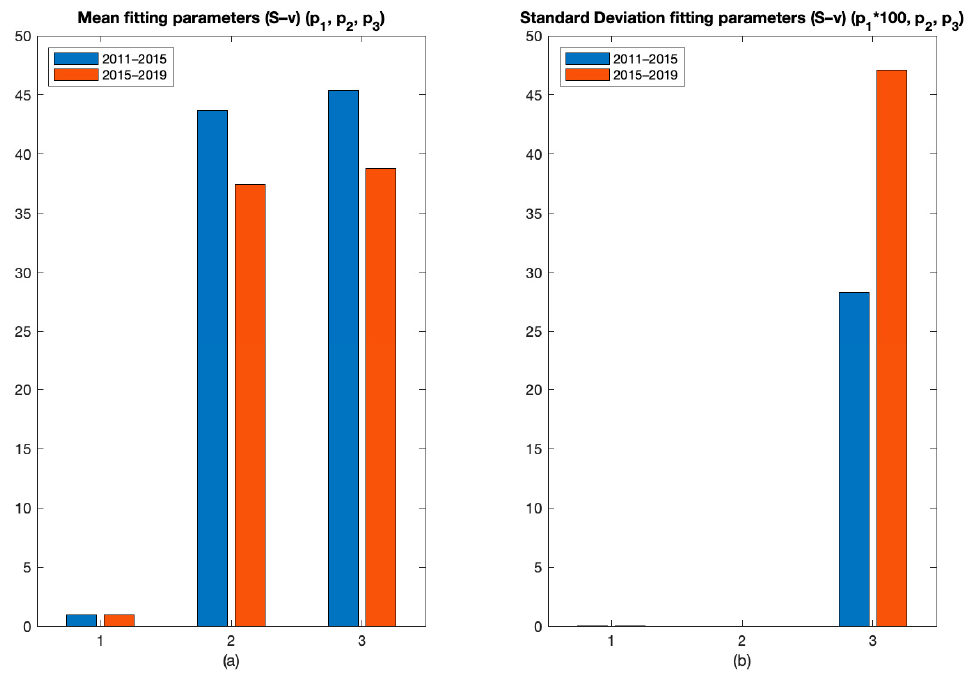
Figure 22. Fitting parameters of the entropy–velocity dispersions in the two periods for the Colos-